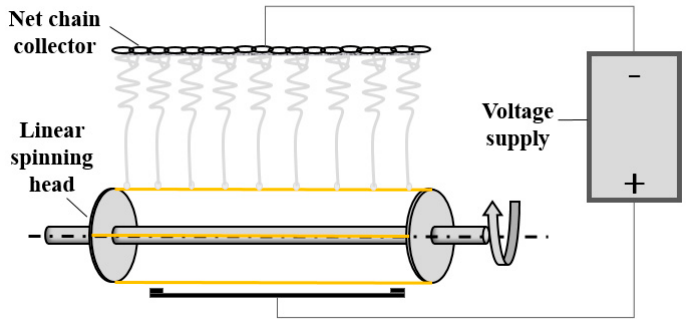
Figure 1. Schematic diagram of the copper linear electrode for electrospun.